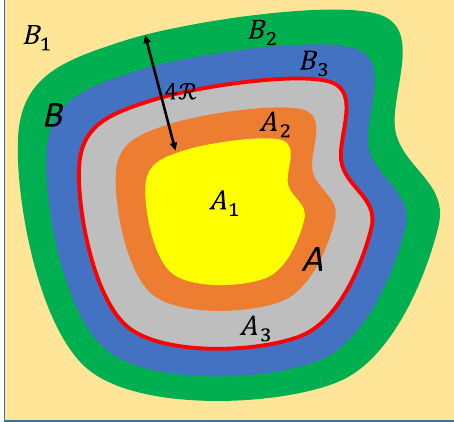
FIG. 2. A sketch for the proof of area-law entanglement for short-range restricted-Boltzmann-machine states. The system is divided into two subsystems, A and B , with the red line showing the interface boundary. In order to show that the Rényi entropy S A α obeys an area law for any α , the subsystem A ( B ) is further divided into three parts: A 1 , A 2 , and A 3 ( B 1 , B 2 , and B 3 ). Since the neural network is short range, the Γ r factors with r ∈ A 1 ∪ A 2 ( r ∈ B 1 ∪ B 2 ) are independent of spin configurations in region B ( A ); thus, we can group the spins in regions A 1 and B 1 with their Γ ρ r factors. The entropy of the reduced density matrix A then only depends on the degree of freedom in region A 2 ∪ A 3 , which is proportional to the surface area of region A . This gives us a clear geometric picture of why S A α is upper bounded by the surface area of A , up to an unimportant scaling constant as given in Eq.